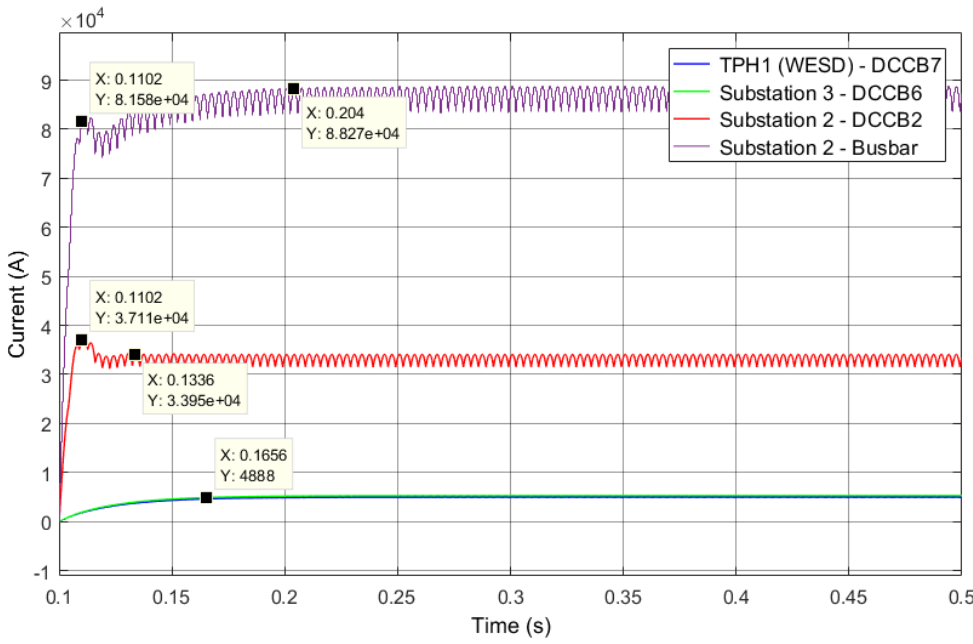
Figure 16. Simulation results of Scenario F3. Fault current (A) vs. time (s) observed with DCCB7 (TPH 1—blue), DCCB6 (Substation 3—green), DCCB2 (Substation 2—red), and the Substation 2 busbar (violet).